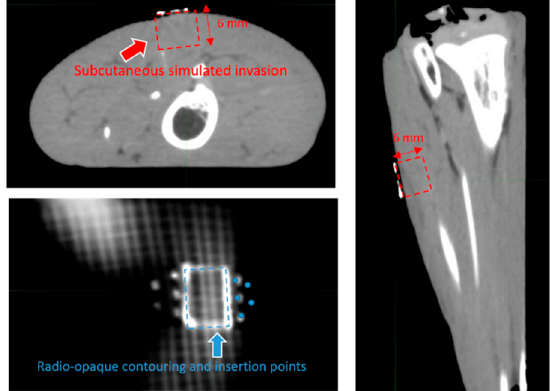
Figure 4. Details of the visibility of the radio-opaque ink in axial coronal and sagittal plane.